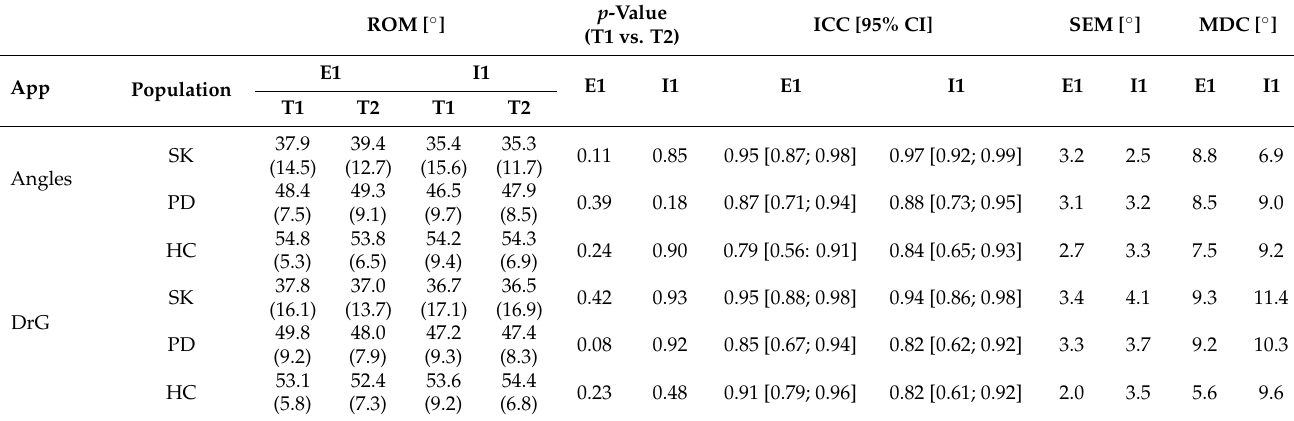
Table 2. Mean values and intra-rater reliability of range of motion measurements acquired by the Angles and DrGoniometer applications by the experienced and the inexperienced raters in the three studied